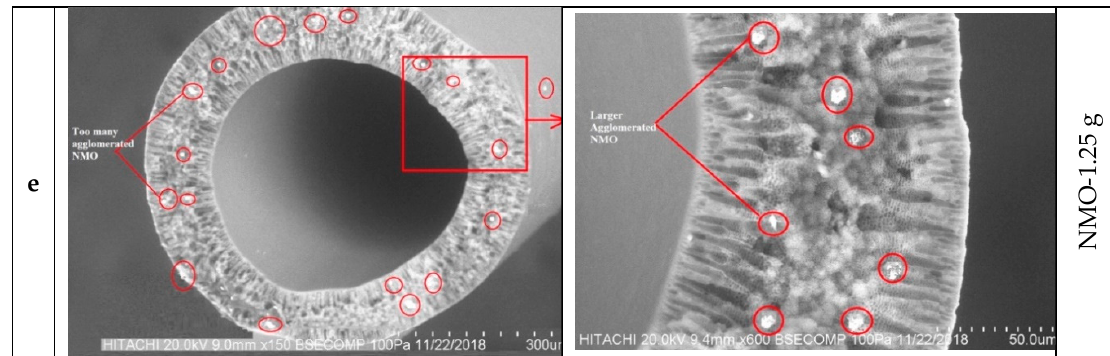
Figure 1. SEM Micro-structure of cross-sectional view of the Spun Fiber: ( a – e ) with different NMO loading.